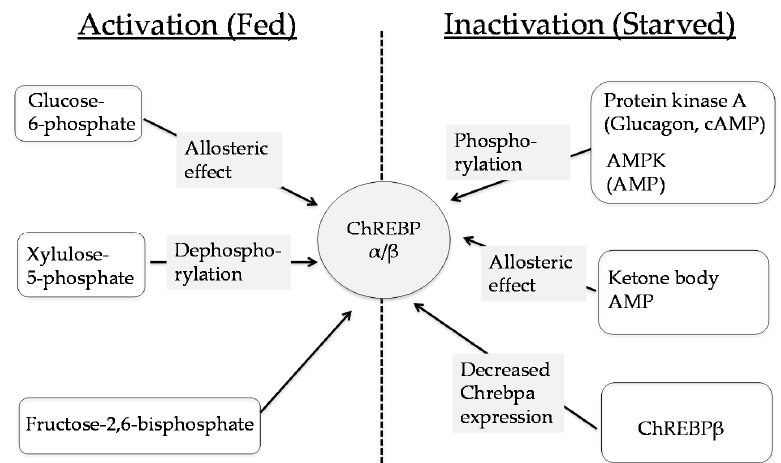
Figure 3. ChREBP transactivities are regulated by several factors. ChREBP is activated by glucose derived metabolites and suppressed by AMP, ketone bodies and cyclic cAMP [43–52]. AMP, adenosine monophosphate; AMPK, AMP-activated protein kinase; cAMP, cyclic AMP.